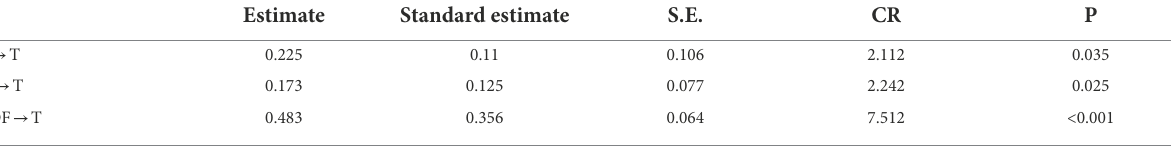
TABLE 5 Pathways from self-interest to tendency to commit fraud corresponding to Figure 4. Estimate Standard